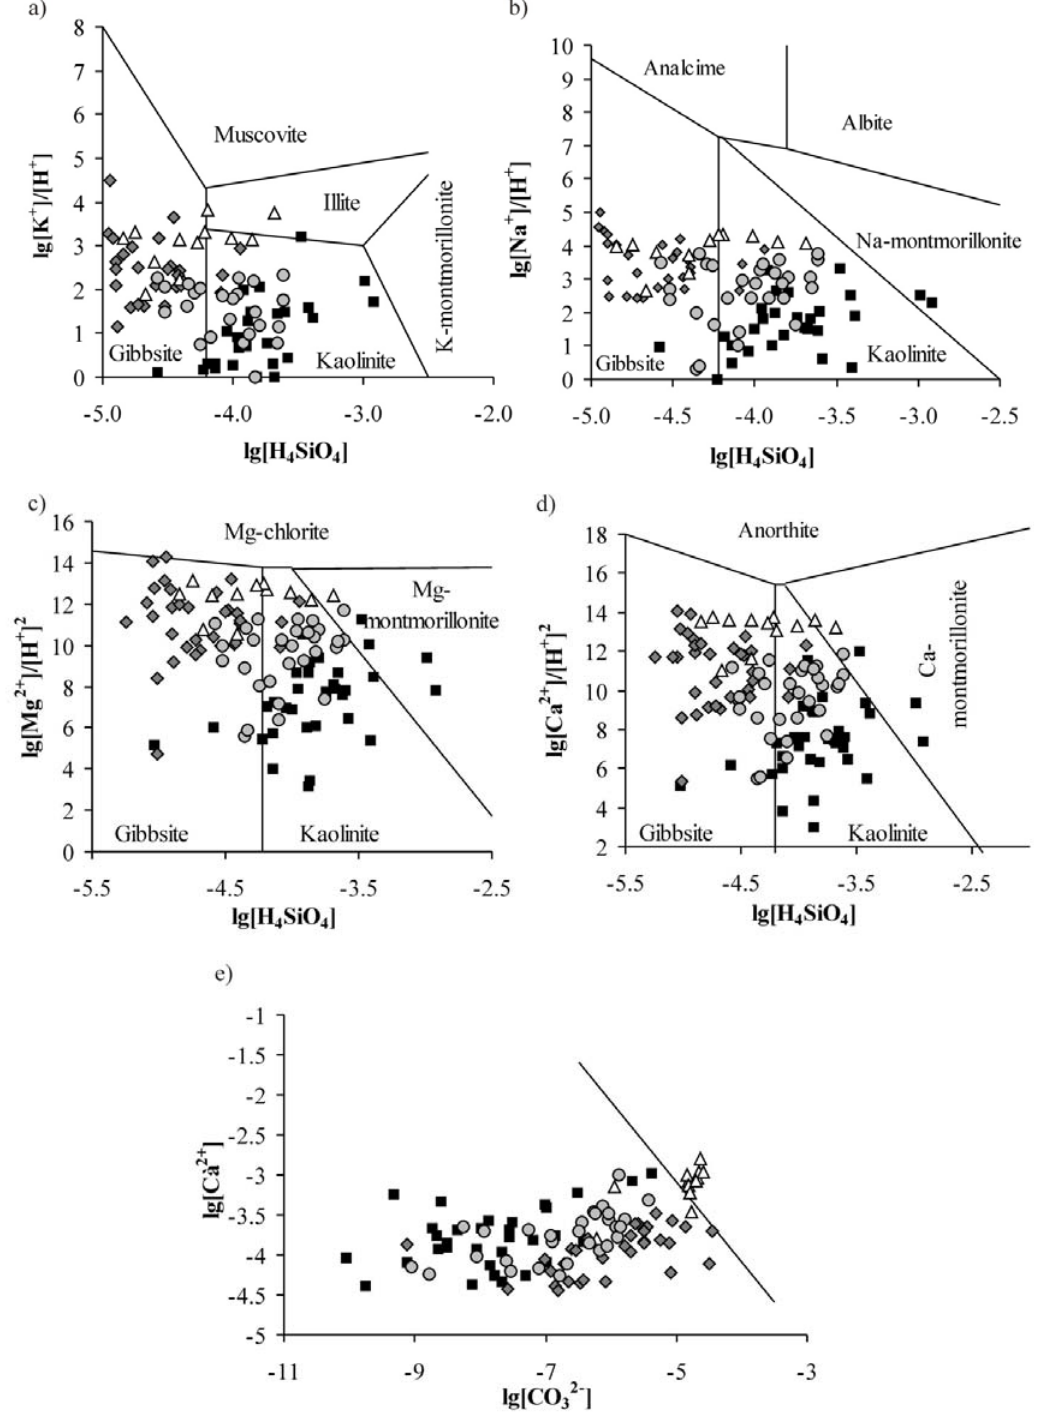
Figure 8. Selected activity diagram in K 2 O–SiO 2 –Al 2 O 3 –H 2 O ( a ); Na 2 O–SiO 2 –Al 2 O 3 –H 2 O ( b ); CaO–SiO 2 –Al 2 O 3 –H 2 O ( c ); MgO–SiO 2 –Al 2 O 3 –H 2 O ( d ) systems and calcite equilibrium diagram ( e ) at 25 °C and 1 bar. Symbols as in Figure 5.